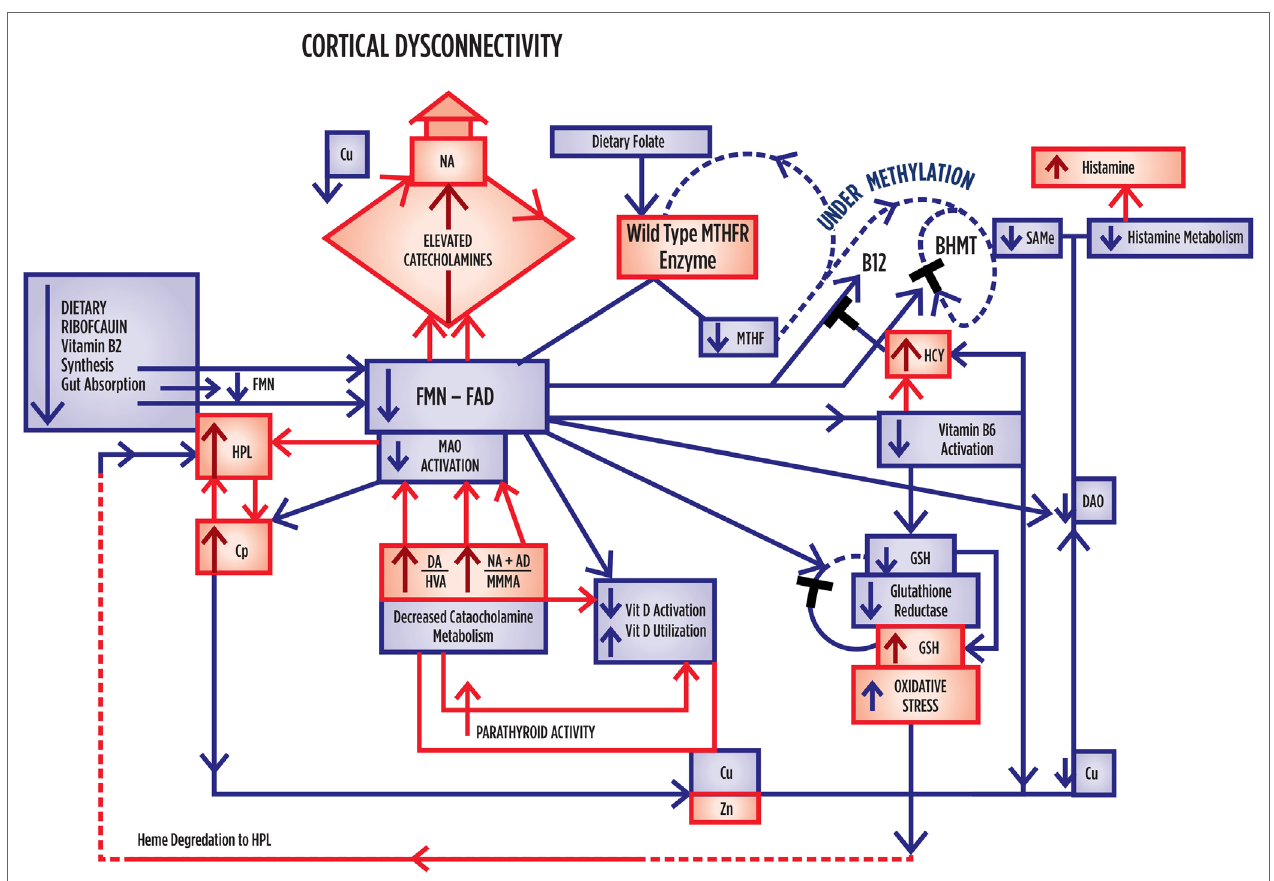
FigUre 3 | summary outcome when there is no MThFr Polymorphism governing activity of the MThFr enzyme, and where folate, vitamins, and flavins are low . Where correlation significance index [SI] = [(1 – P -value) × 1000], caseness for schizophrenia or schizoaffective disorder relates to NA [SI = 100] and HPL/Creatinine [SI = 93], in a setting where catecholamines held significant correlates with the wild-type enzyme and where NA relates to SIR